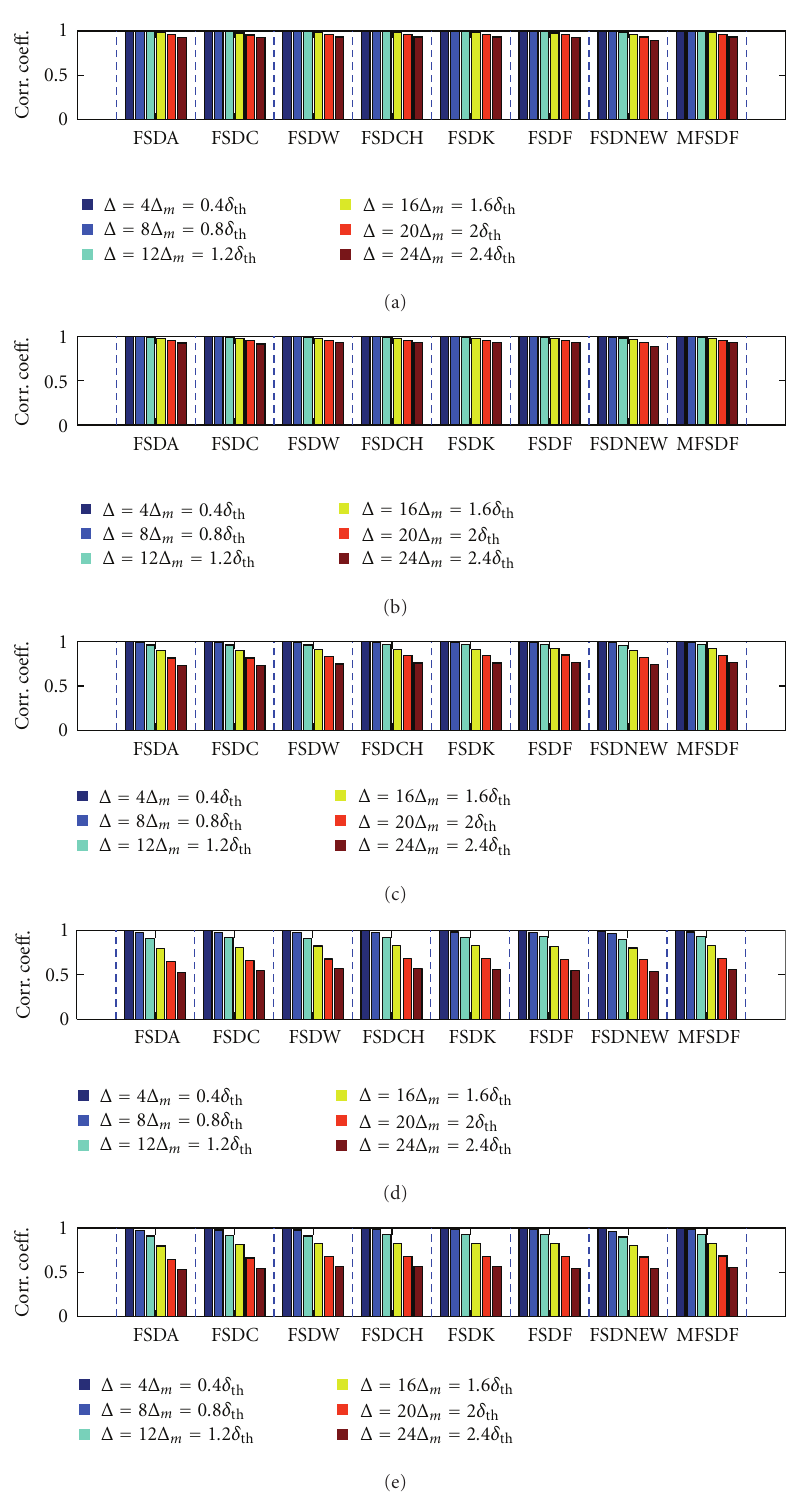
Figure 6: Correlation coe ffi cients between modelled and actual values of Σ gen in the c range 0 . 1 ≤ c ≤ 0 . 9 for Δ = 4 Δ m = 0 . 4 δ th ; Δ = 8 Δ m = 0 . 8 δ th ; Δ = 12 Δ m = 1 . 2 δ th ; Δ = 16 Δ m = 1 . 6 δ th ; Δ = 20 Δ m = 2 . 0 δ th and Δ = 24 Δ m = 2 . 4 δ th for (a–e) cases